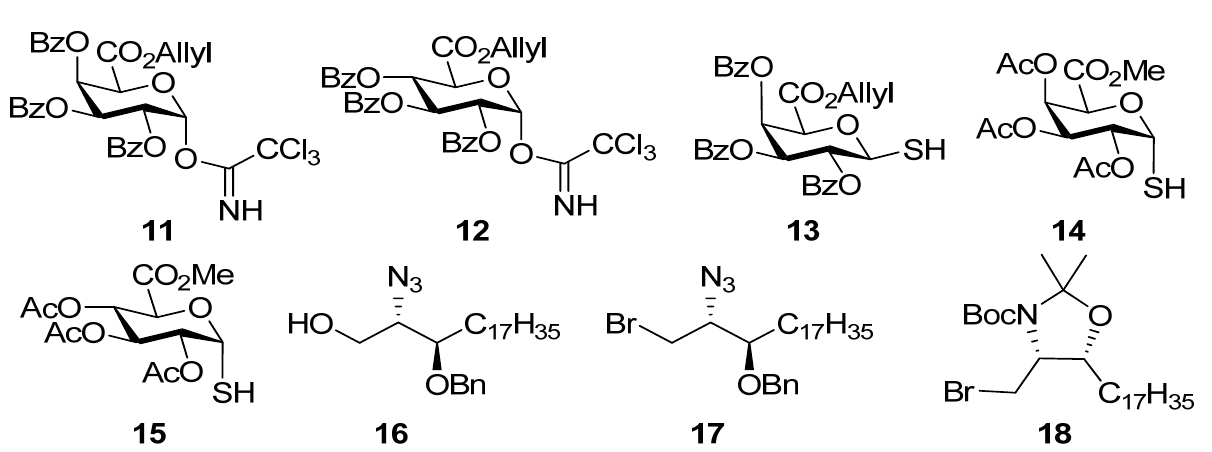
Figure 2. Structures of key building